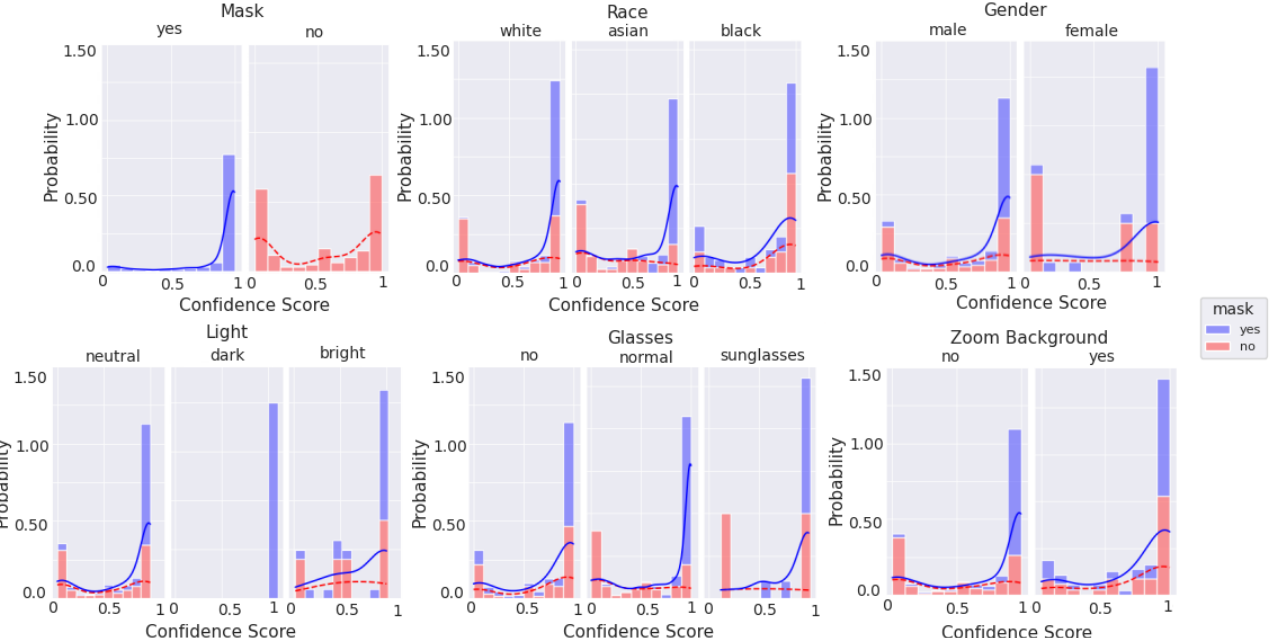
Figure 12. Histogram of categorical labels vs. confidence scores for only good quality images, as qualitatively evaluated, using the augmented MobileNetv2 model. For each category and its labels, ‘mask’ and ‘no mask’ data bins are stacked. The solid and dashed lines represent the KDE for ‘mask’ and ‘no mask’ image scores, respectively.